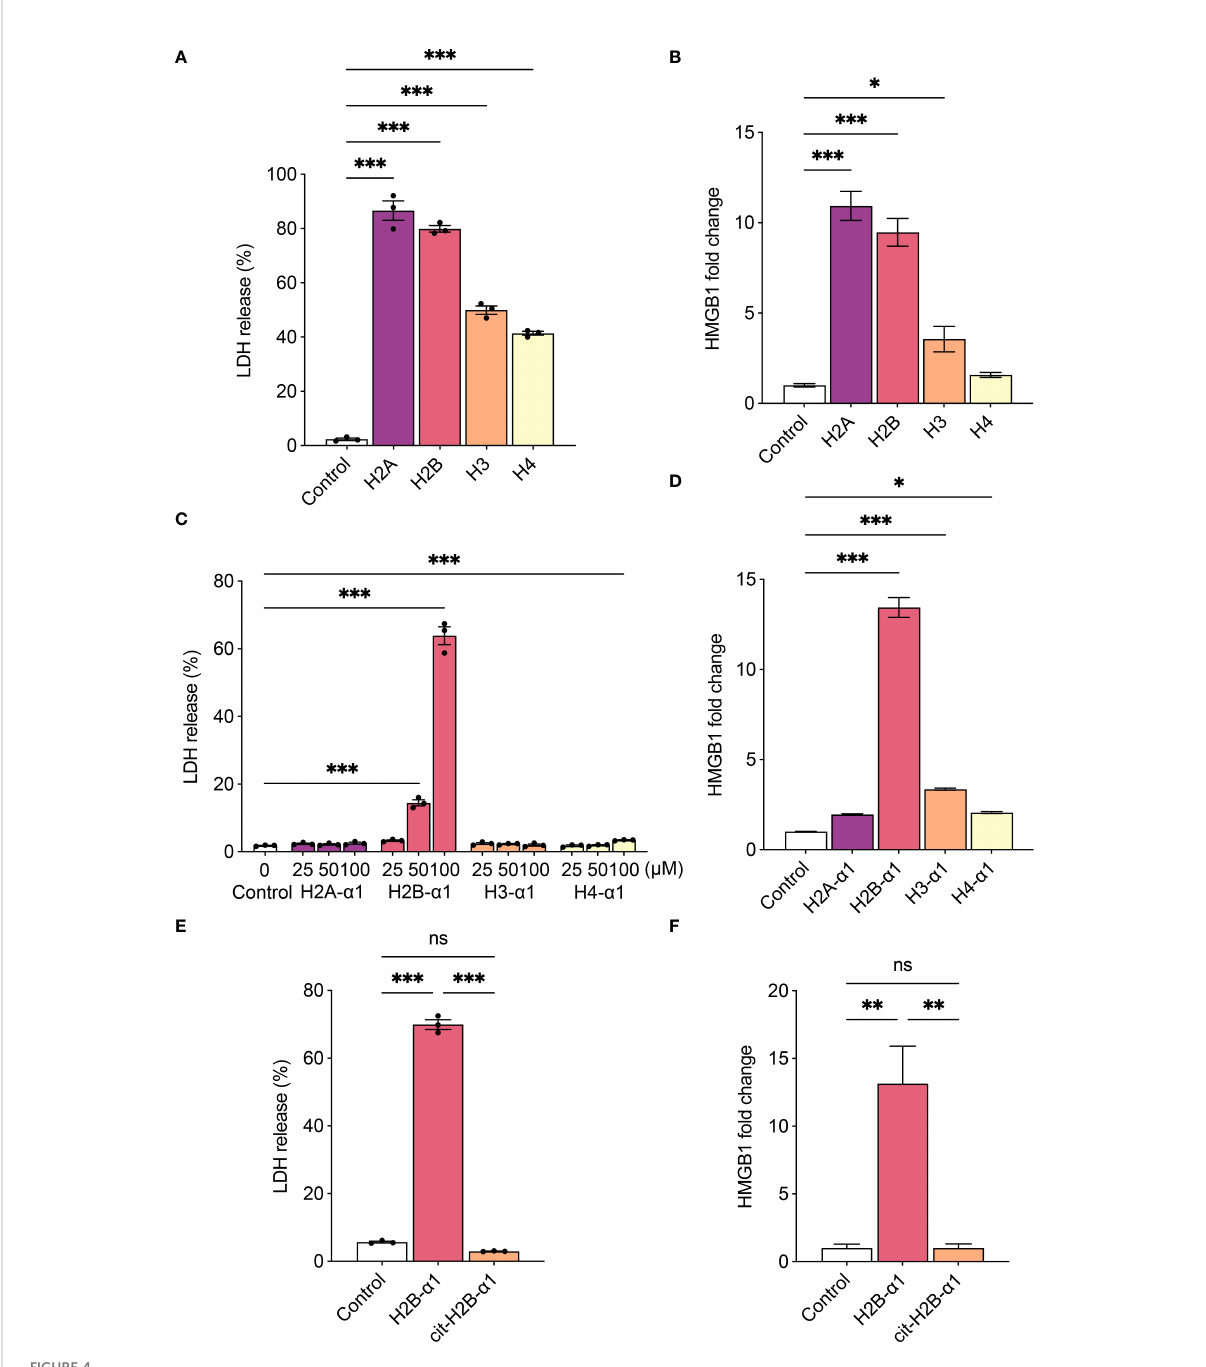
FIGURE 4 H2B- a 1 peptide induces cytotoxicity in macrophage. (A) , (B) Histone-induced cytotoxicity (3 h) with each class of recombinant histone proteins (4 m M). (C) , (D) Histone-induced cytotoxicity (24 h) with each class of histone a 1 peptides. (E) , (F) Histone-induced cytotoxicity (24 h) with native or citrullinated (cit) H2B- a 1 peptide (50 m M). Cytotoxicity levels were measured by lactate dehydrogenase (LDH) release assay (A, C, E) , and HMGB1 release was measured by luciferase assay (B, D, F) . Data are expressed as the mean ± standard error of the mean. ANOVA with Tukey – Kramer multiple comparison tests were conducted. * P < 0.05, ** P < 0.01, and *** P < 0.001. ns, not signi fi cant.. The experiments were performed with technical replicates of three wells per condition. See table 1 for sequences of